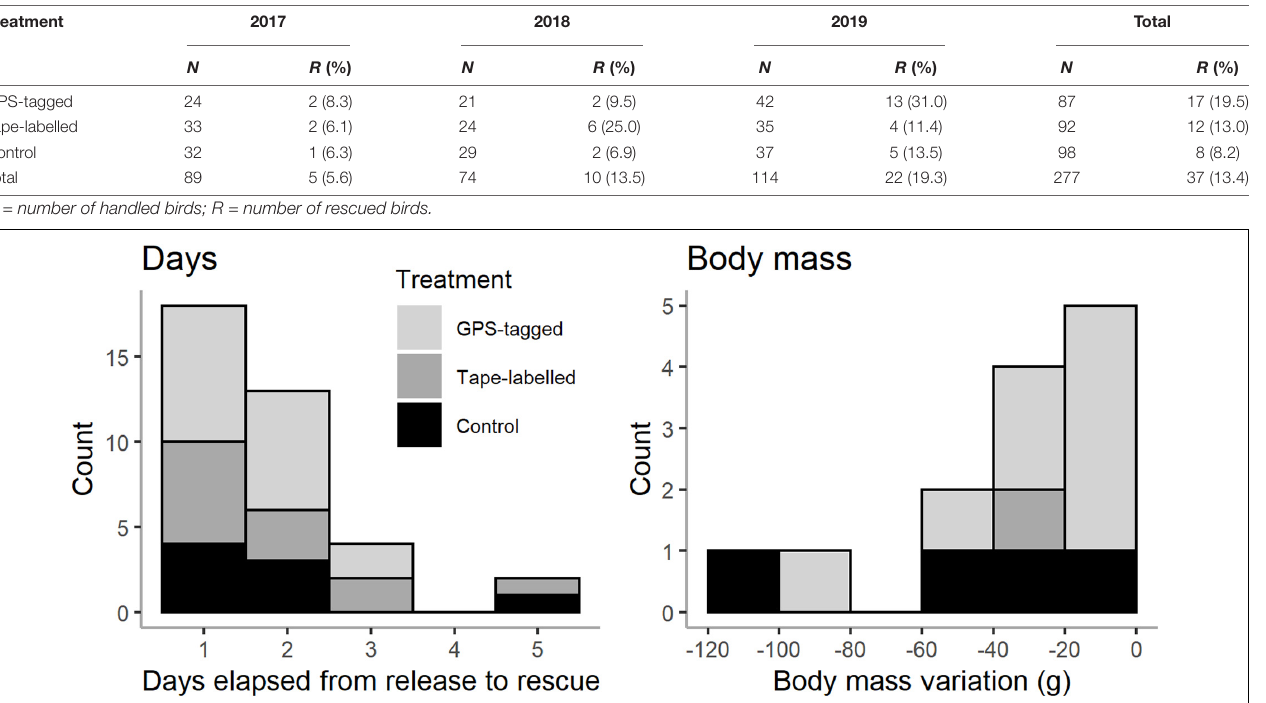
FIGURE 1 | Histograms of the days elapsed from release to rescue and body mass loss between experimental release date and rescue date.